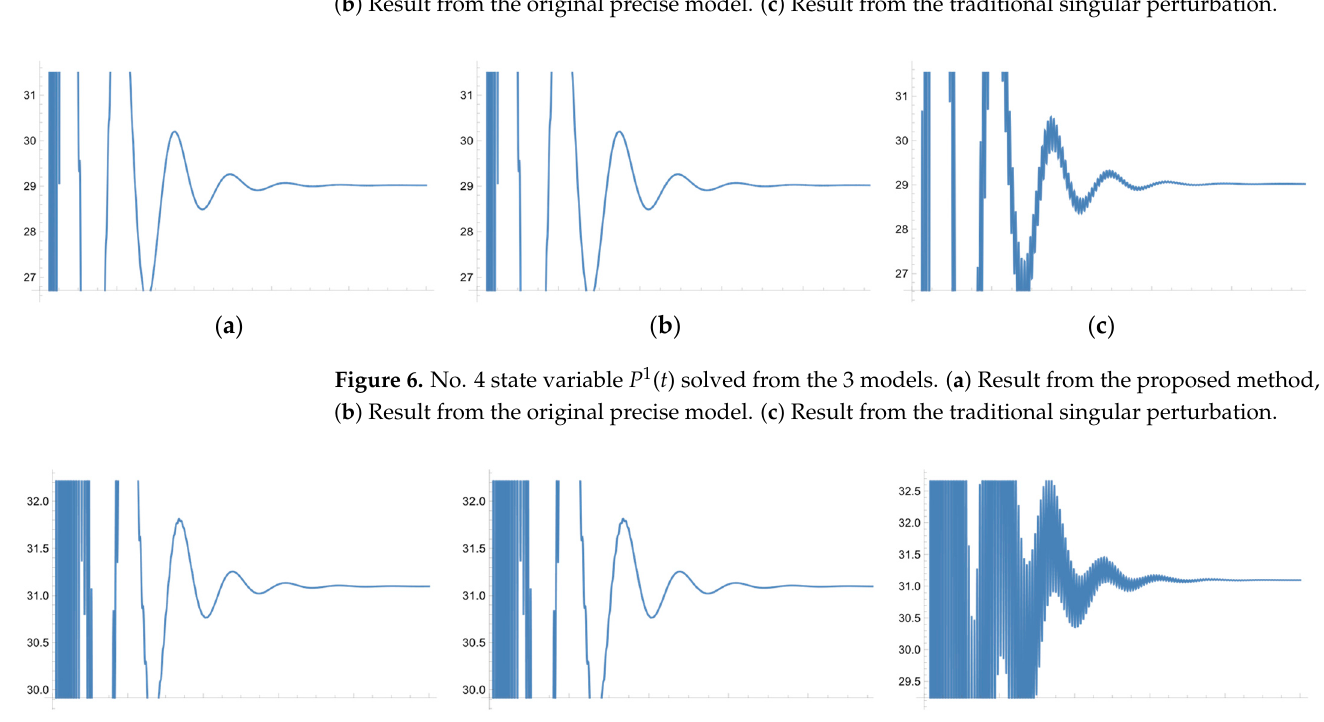
Figure 5. No. 2 state variable V Cdc ( t ) solved from the 3 models. ( a ) Result from the proposed method, ( b ) Result from the original precise model. ( c ) Result from the traditional singular perturbation.